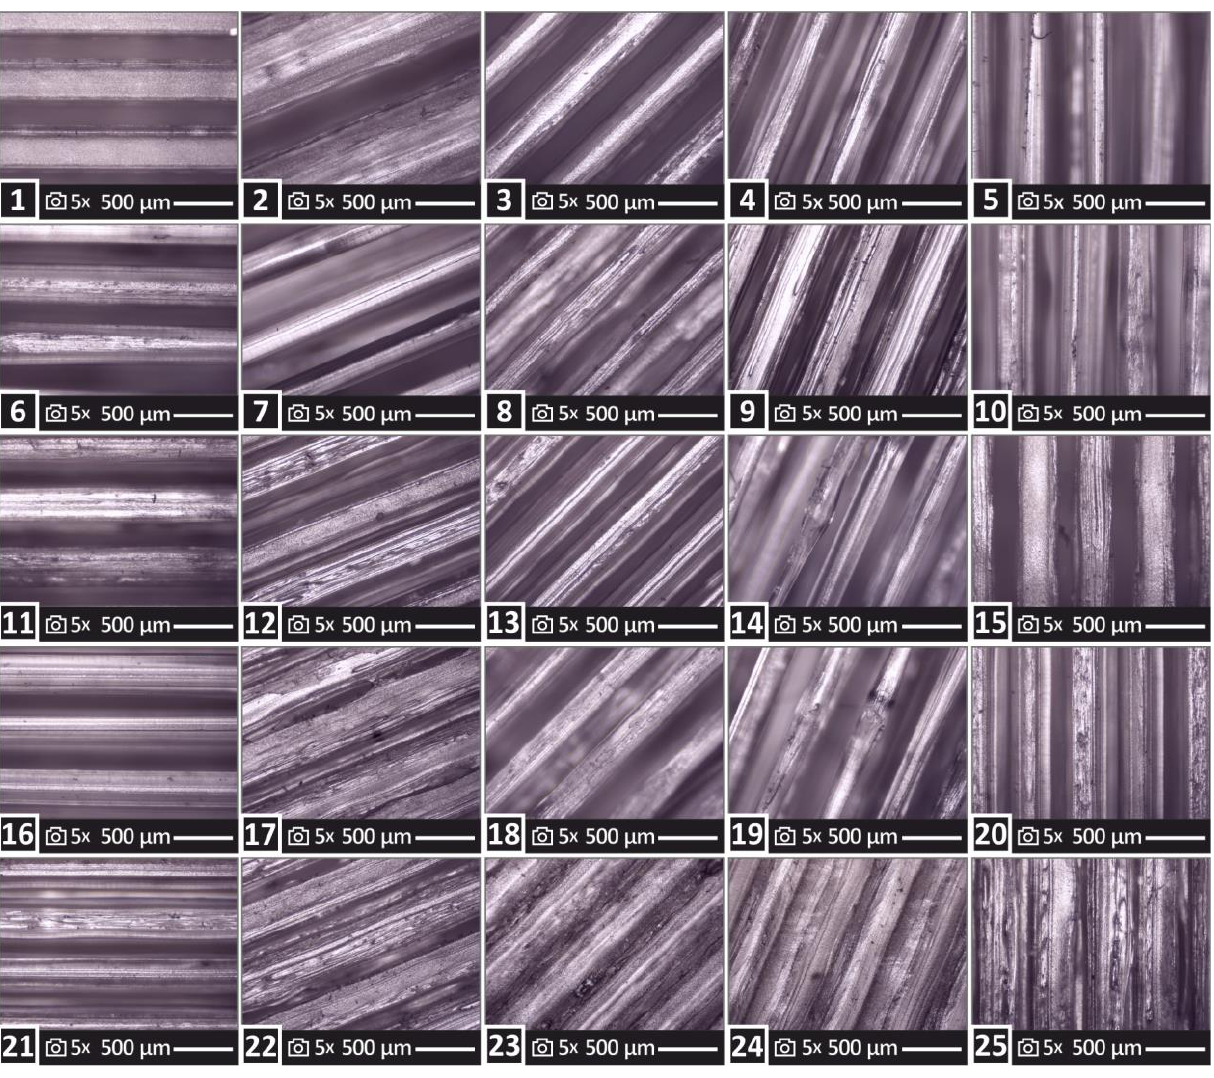
Figure 3. Images from the optical stereoscope of the top surface of one of the five samples for each one of the twenty-five runs studied in the work. The differences in the samples’ 3D-printing structure are visible in the images. The number in the images is the corresponding run from which the image was taken.